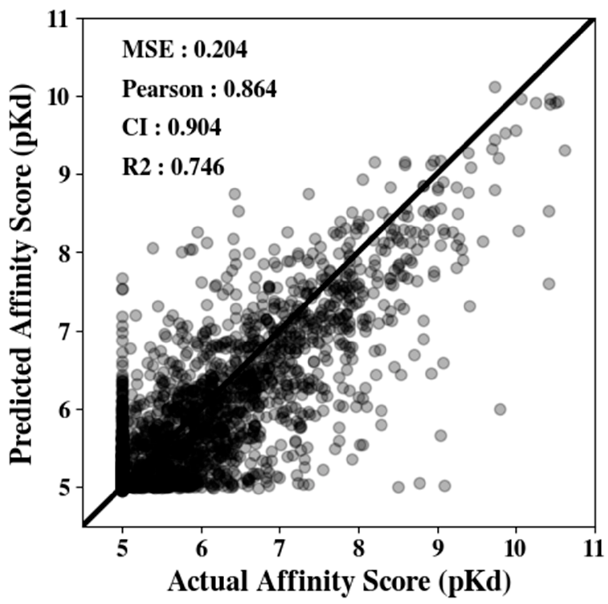
Figure 3. Prediction from the GraphATT-DTA model on the Davis testing data. The scatterplot shows the trend of the predicted affinity values vs. actual affinity values (pKd). The black line represents y = x . CI, concordance index; MSE, mean-squared error; Pearson, Pearson correlation; R2, r squared.